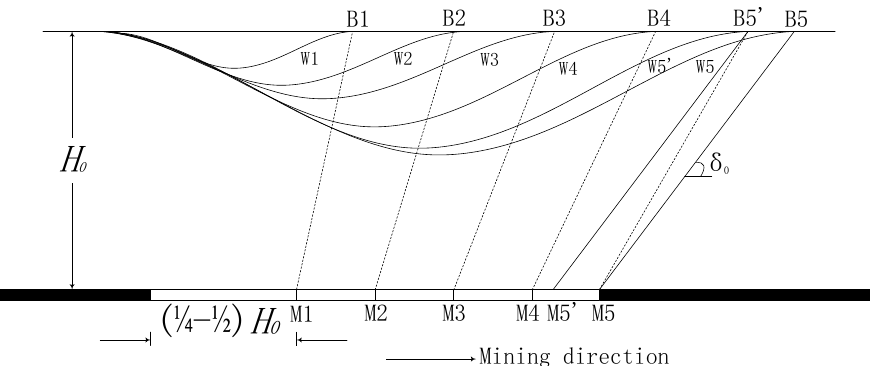
Figure 3. Schematic diagram of dynamic surface subsidence.